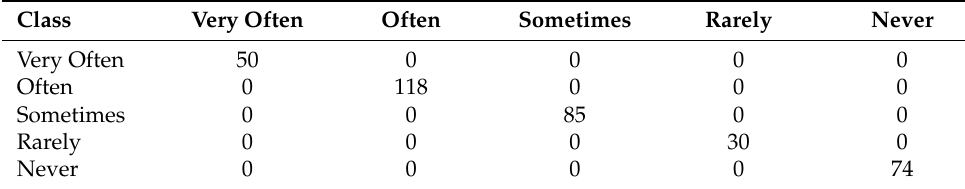
Table 2. Confusion matrix for decision tree.